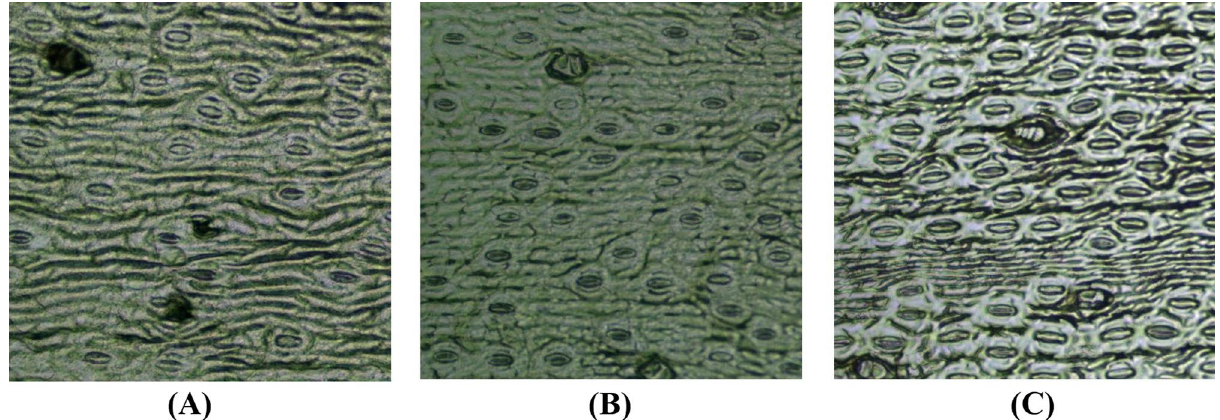
Figure 2. Representative stomata tiles for three palms’ developmental stages collected in this study. ( A ) 1 yo palm seedling, ( B ) 2–3 yo juvenile palm, ( C ) > 10 yo adult